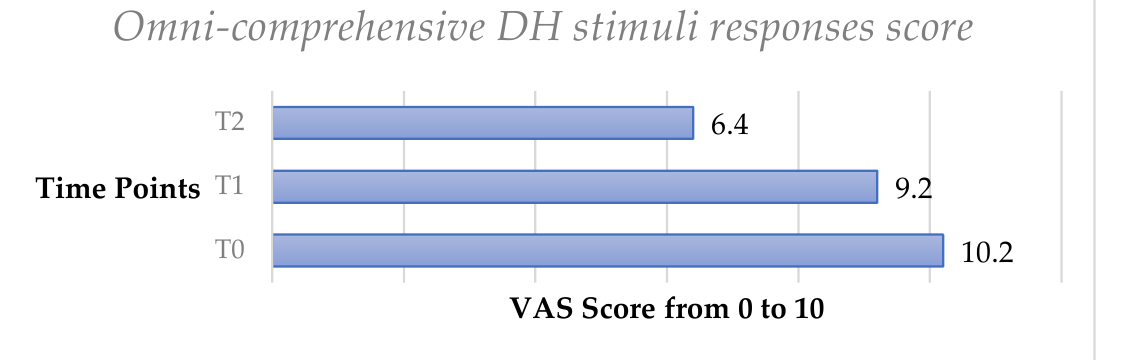
Figure 8. Mean values of omni-comprehensive DH stimuli responses score trend from T0 to T2 in the whole sample.